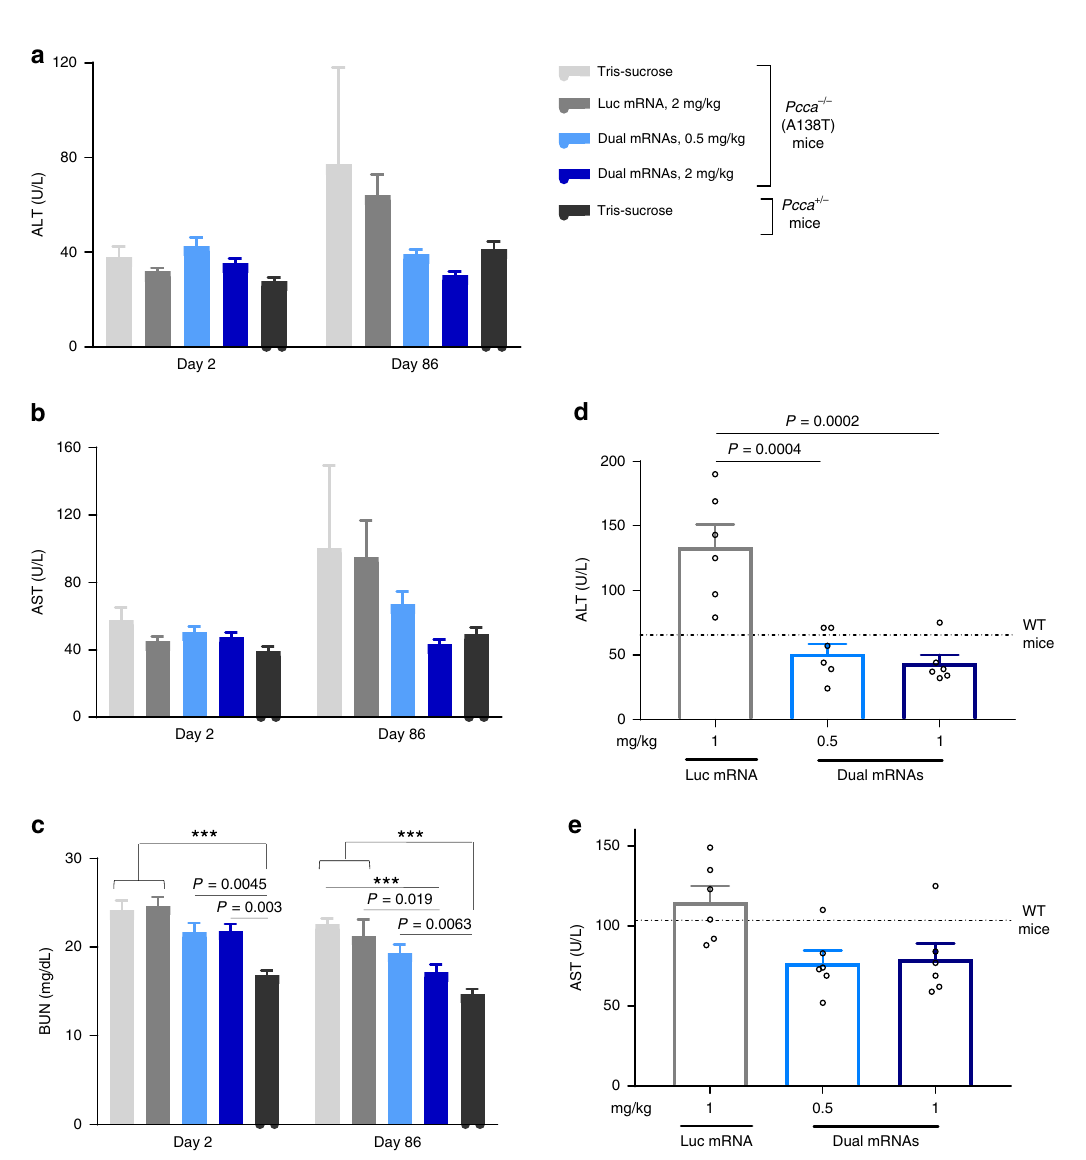
Fig. 4 Dual mRNAs are well-tolerated in 3- and 6-month repeat-dose studies in PA hypomorphic mice. a – c Select clinical chemistry parameters (serum ALT, AST, and BUN) in PA hypomorphic and unaffected mice ( n = 12/group/sacri fi ce time point) from the 3-month study. d , e Select clinical chemistry parameters (plasma ALT and AST) in PA hypomorphic female mice ( n = 6/group) from the 6-month study. The dotted lines indicate the mean values from n = 5 untreated WT age-matched female mice. Levels of plasma ALT and AST in these untreated WT mice were 65.60± 9.49 and 103.60 ± 14.15 U/L, respectively (one outlier was excluded). Data are presented as mean ± SEM. P values were obtained from Tukey ’ s post hoc pairwise multiple comparison test following a one-way or two-way ANOVA, and are provided in the source data. *** P < 0.001. ALT alanine aminotransferase, AST aspartate